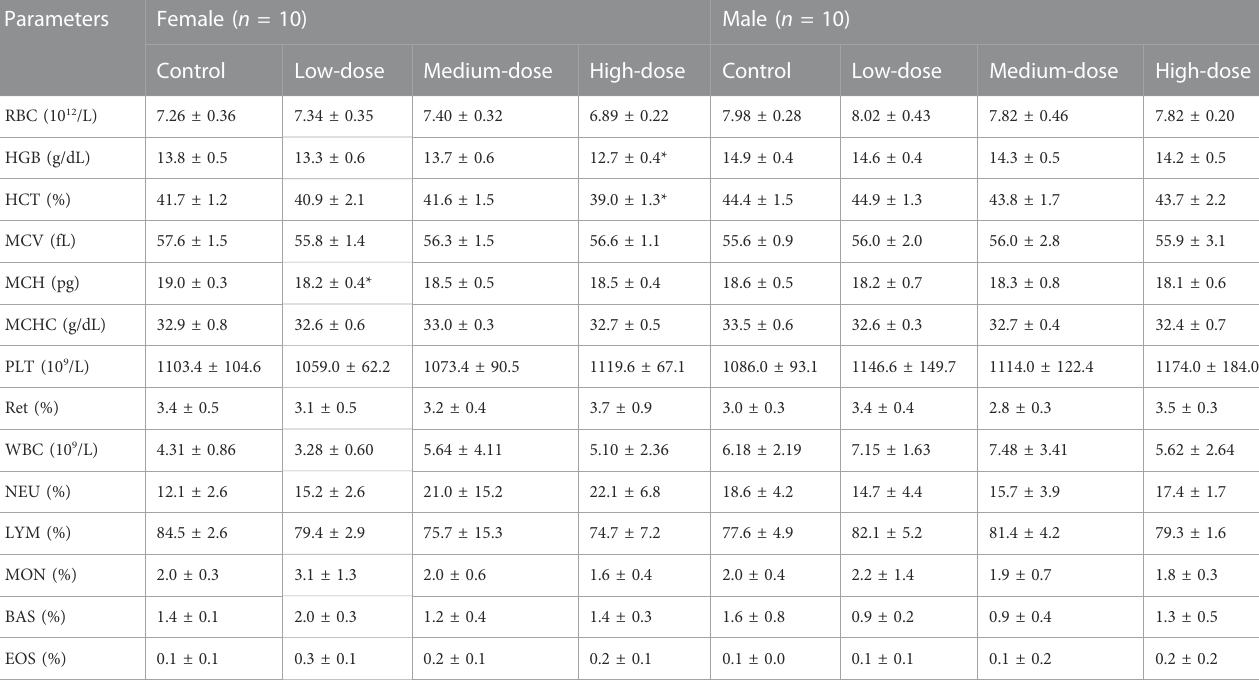
*Indicates p ≤ 0.05 as compared to control group.